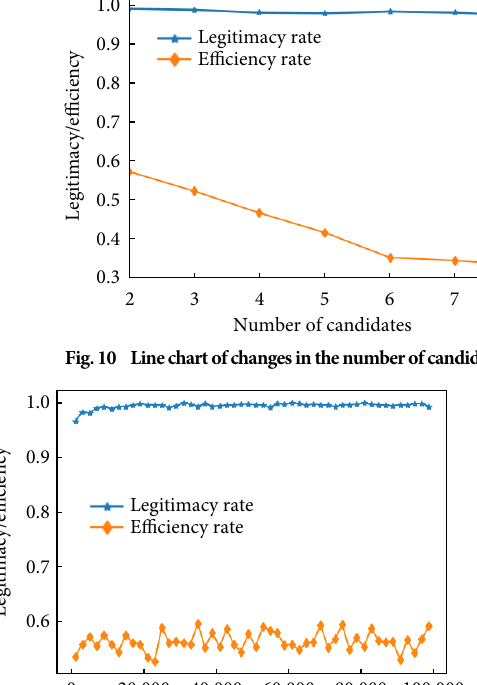
RightNumber of voters Fig. 11 Change curves of legitimacy/effciency when the numbers of candidates are 3 ((a) Left) and 4 ((b)